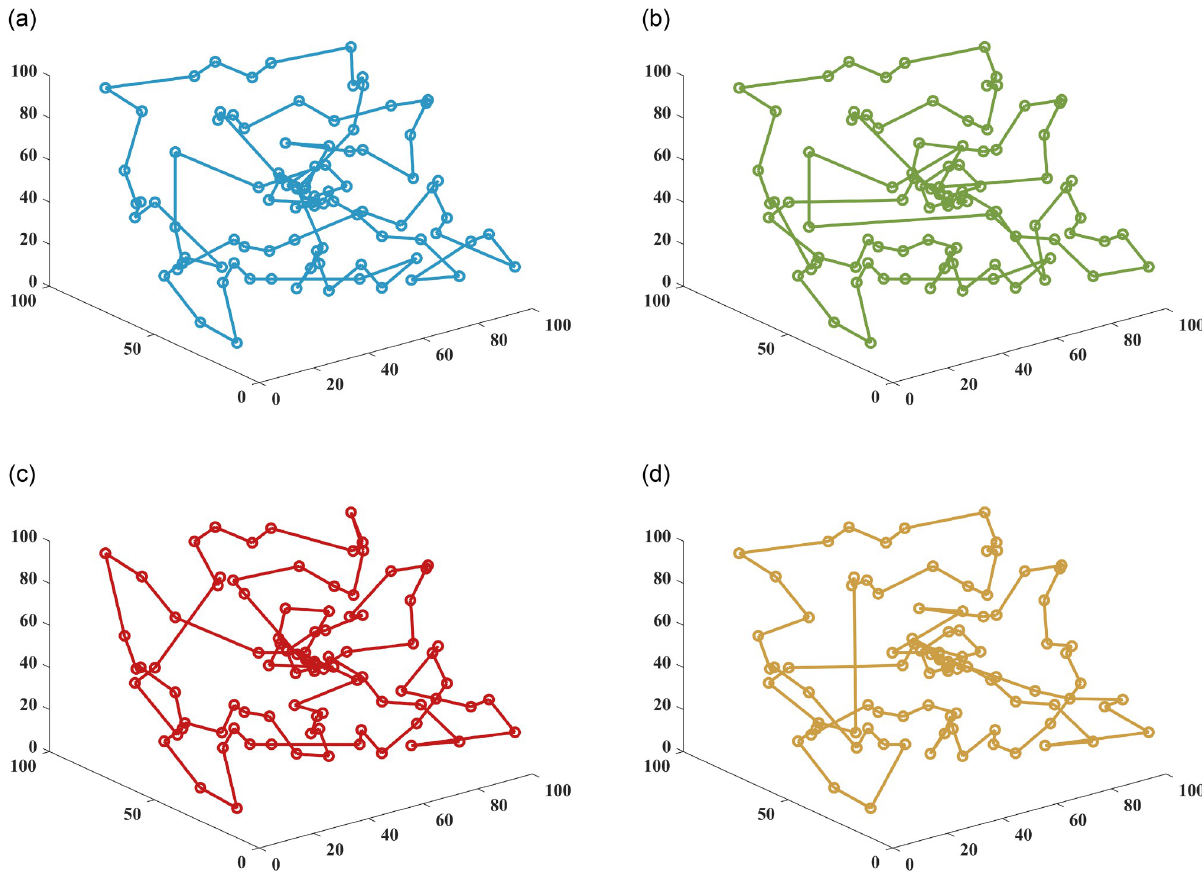
Fig 7. Picked roadmap obtained by four algorithms under 90 fruits. (a) ACO Picking Path. (b) ASrank Picking Path. (c) IACO Picking Path. (d) OSACO Picking Path.